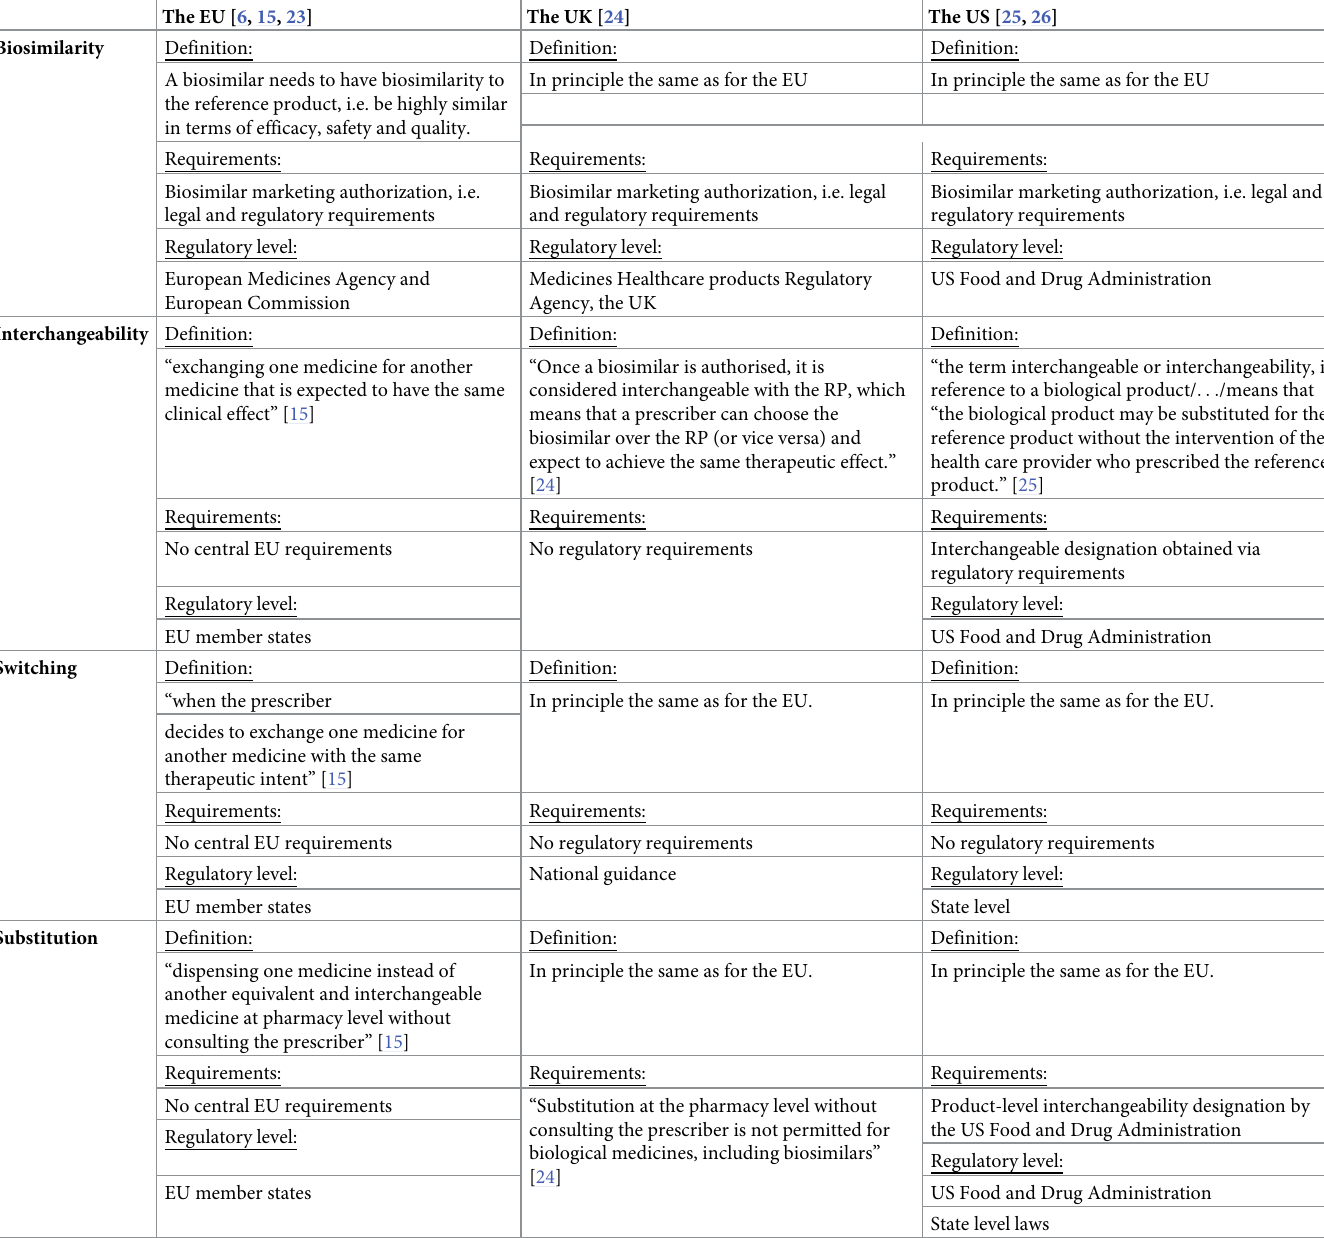
Table 1. Definitions, requirements and regulatory level of responsibility of biosimilarity, interchangeability, switching and substitution in the EU, the UK and the US. The EU [6, 15,